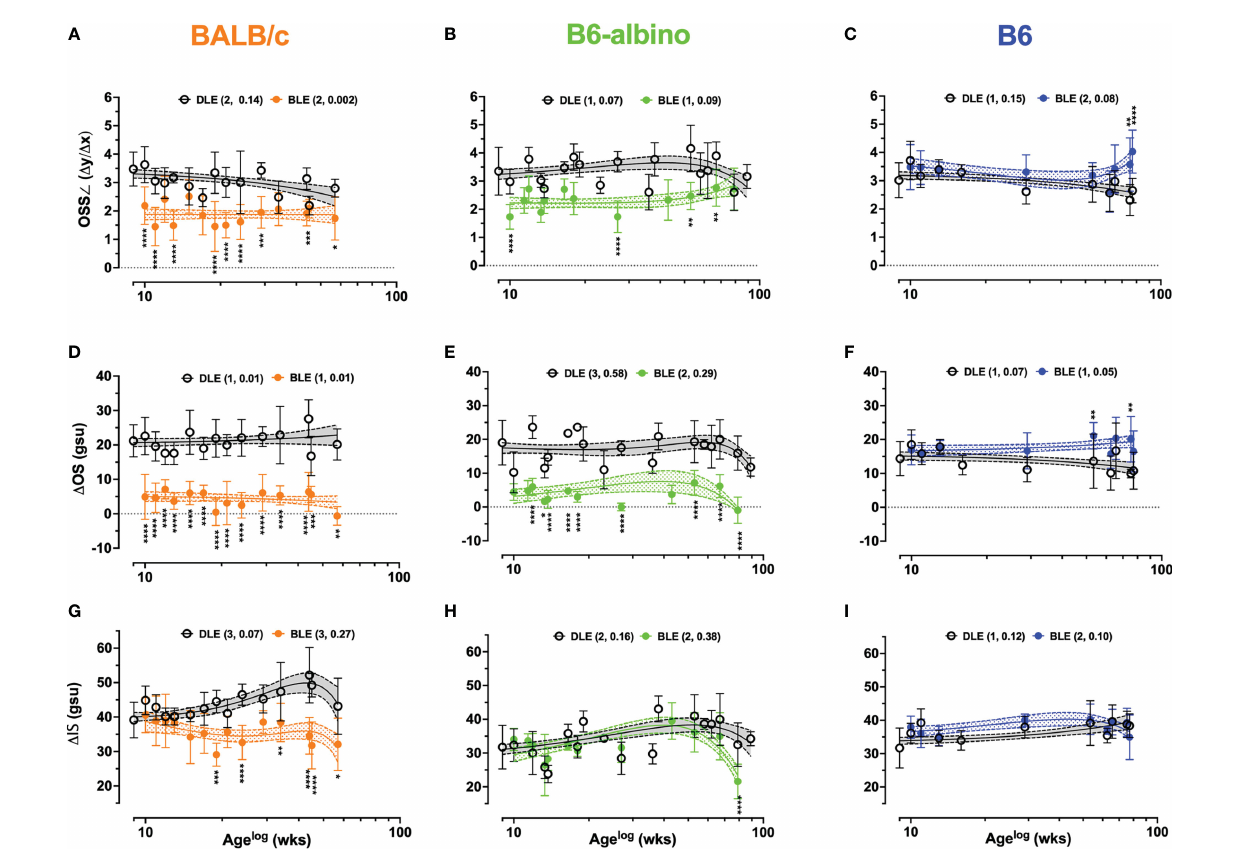
FIGURE 4 Dynamic trends extracted from LRP data for Analyses #4-6 in BALB/c, B6-albino, and B6 mouse strains. Trends between DLE vs. BLE groups are displayed for: Analysis #4 of the OS signal slope (OSS ∠ ) (A – C) , Analysis #5 of the D OS (D – F) , and Analysis #6 of the D IS (G – I) . Datapoints show mean+/-SD and curve fi t are mean+/-95% CI. Legends indicate the curve fi t polynomial order and R-squared in parenthesis for both DLE and BLE